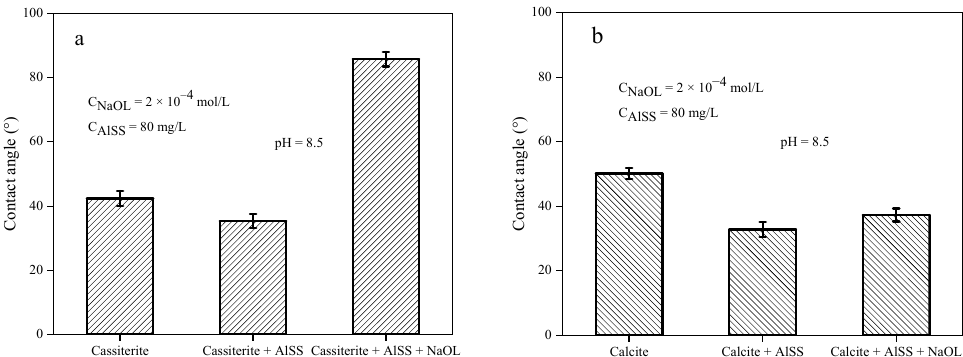
Figure 12. Contact angle of cassiterite ( a ) and calcite ( b ) in different systems.